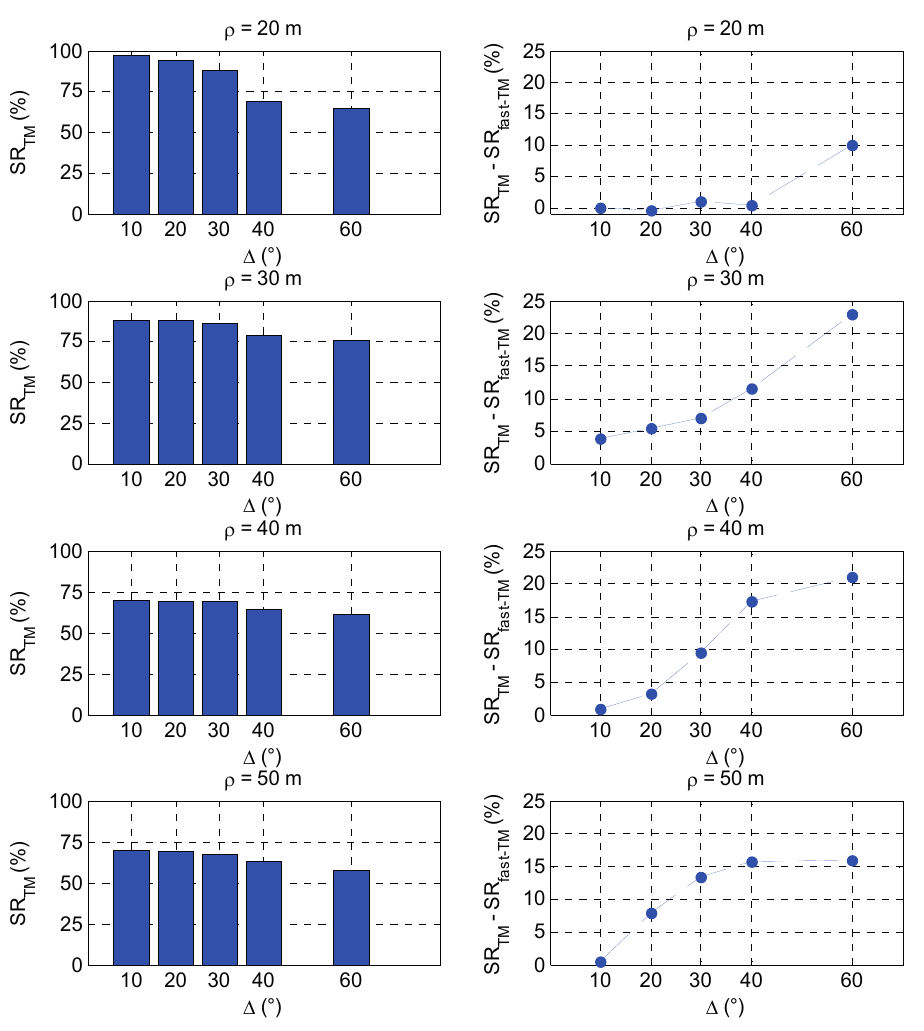
Figure 8. ( Left ) SR TM as a function of Δ at different ranges; ( Right ) Variation of SR fast.TM -TM with respect to SR TM as a function of Δ at different